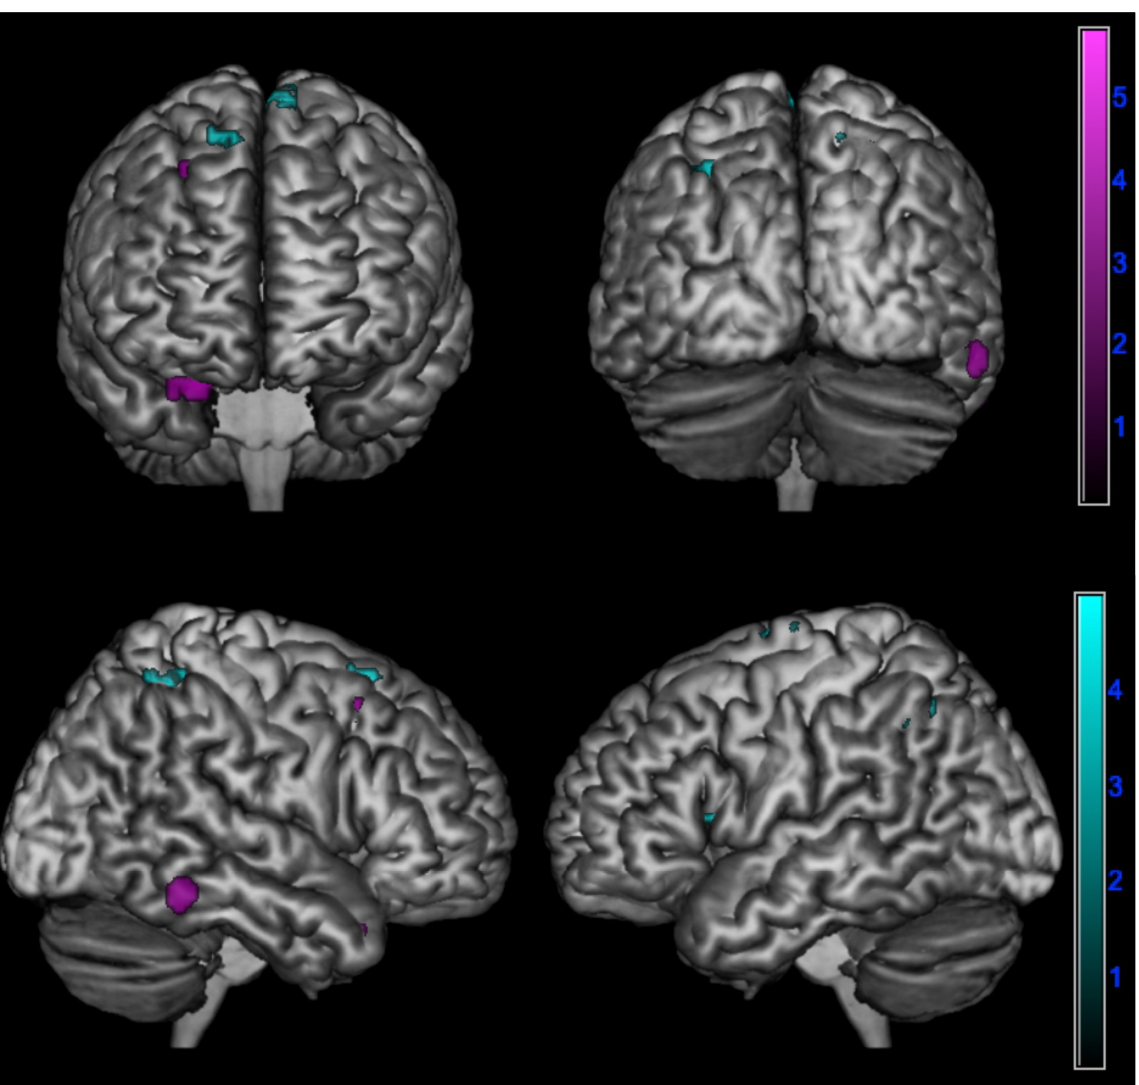
Figure 3. Negative correlation between changes in perspective taking ability over time assessed by ∆ PT (PT-T0 - PT-T1) and brain metabolism in logopenic primary progressive aphasia and amnesic Alzheimer’s disease patients at 18F-FDG-PET SPM analysis. Significant clusters projected on the standardized Montreal Neurological Institute (MNI) magnetic resonance imaging (MRI) render surface. Color grading: cyan, lv-PPA; violet, amnesic AD. A positive correlation between ∆ PD and brain metabolism was